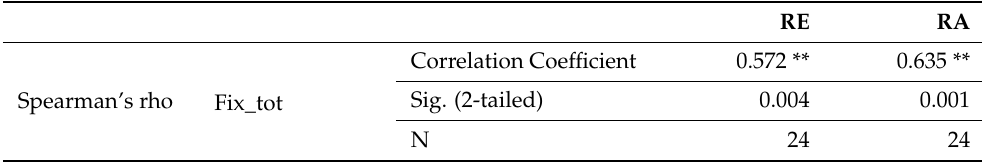
Table 13. Correlations.